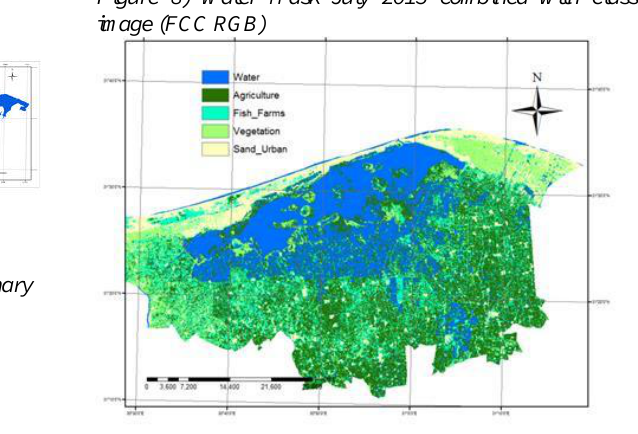
Figure (9) Classification Map May